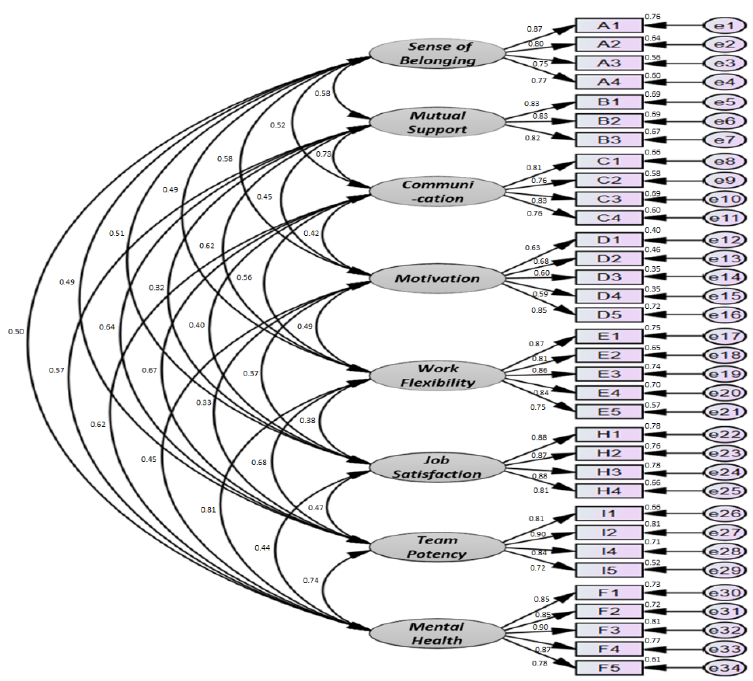
Figure 3. Confirmative factor analysis results. Table 2. Results of confirmative factor analysis and confidence